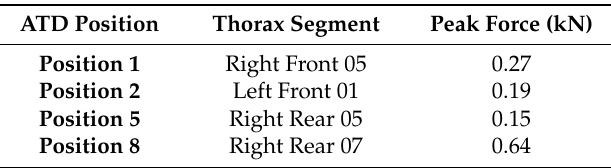
Table 11. Peak thoracic force and pressure.